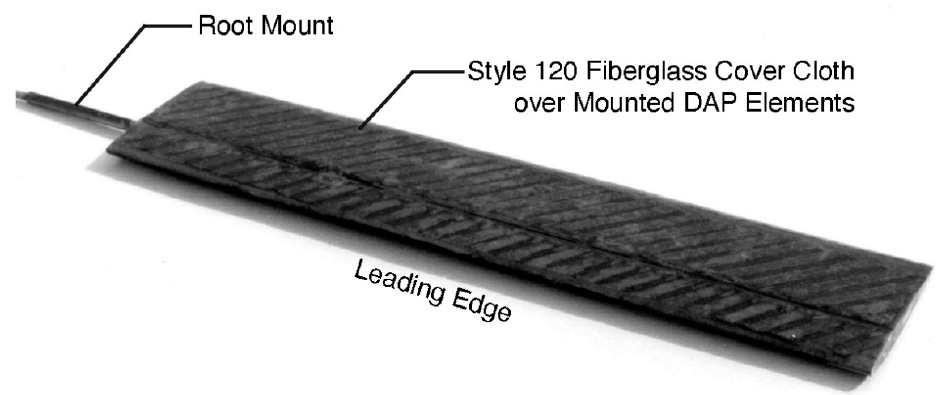
Figure 6. DAP elements under fiberglass cloth and AISI 1100-H19 pre-compression sheets bonded to a polystyrene foam core with a root connector.